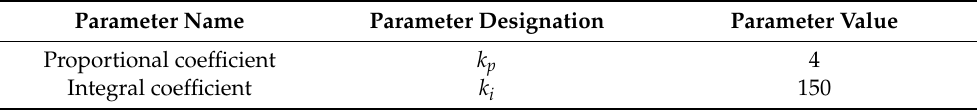
Table 2. Parameters of PI motor speed controller.